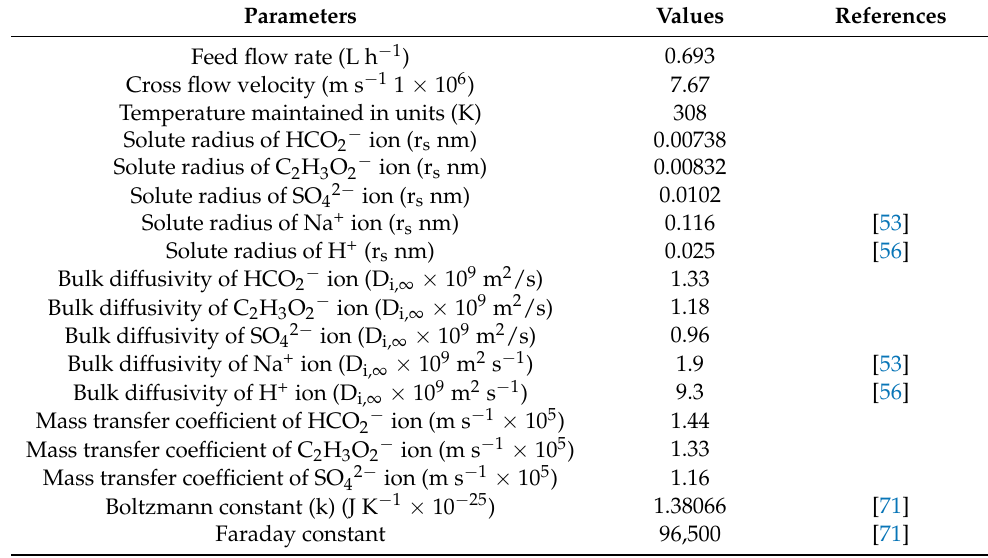
Figure 6. Comparison between experimental data and model results for the ternary salts in 45 wt. % MDEA solution by NF membrane at 70 bar, 35 ◦ C, pH = 10 and feed flow rate of 0.693 L/h. Table 2. Model parameters and physical properties of ions at 35 ◦